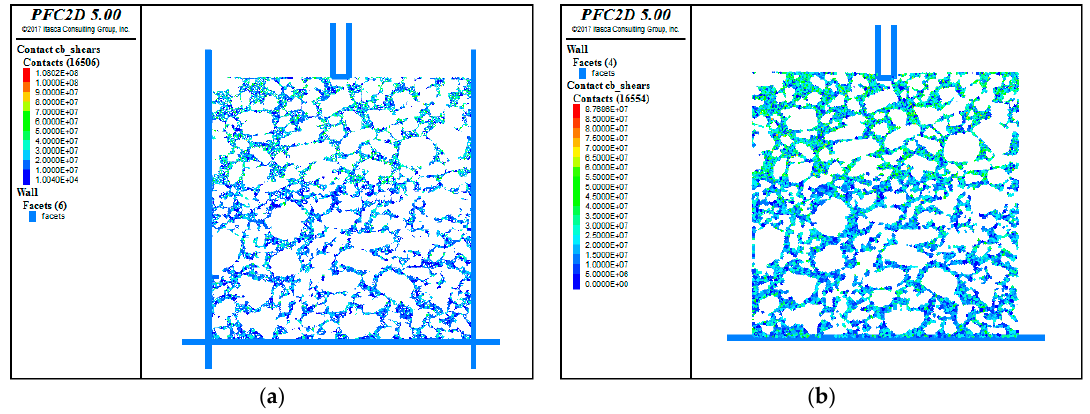
Figure 17. Comparison of shear stress within the asphalt mortar before and after the test. ( a ) Before the test; ( b ) After the test.